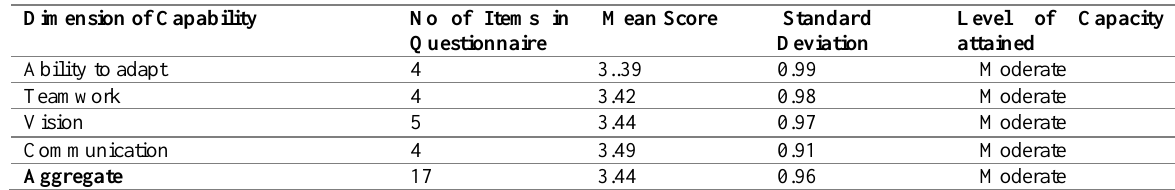
Table 3: Level of Emergent Capability